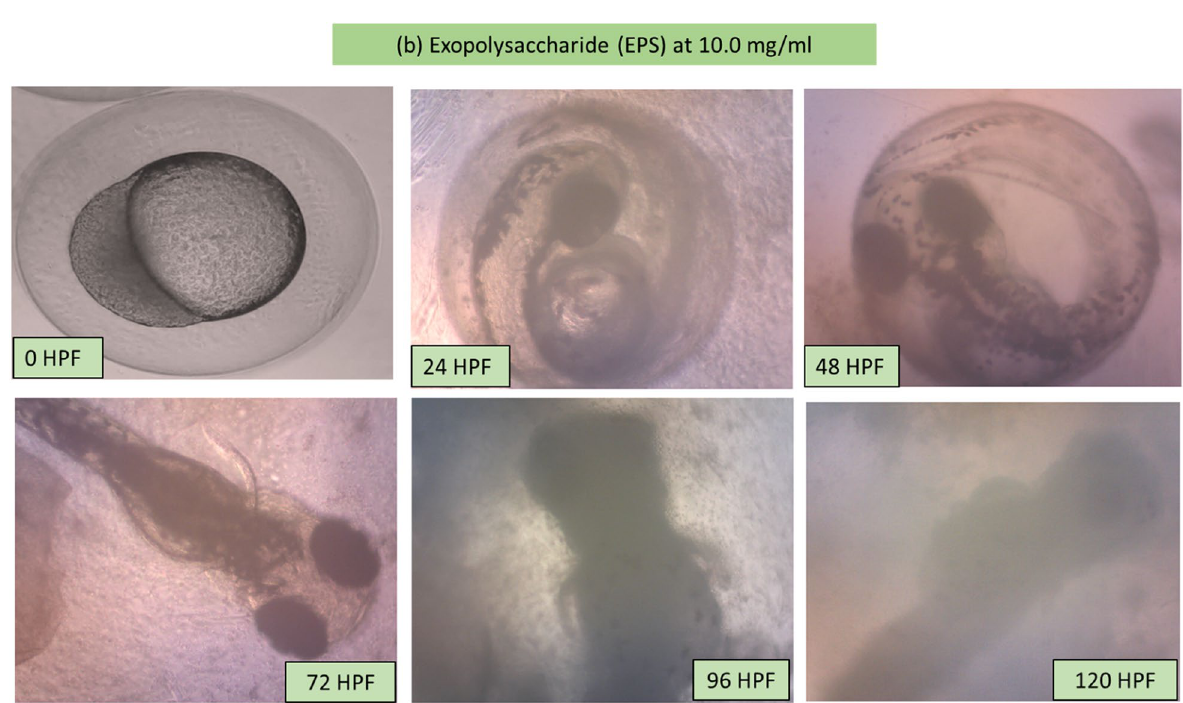
Figure 9. Illustrations of zebrafish embryo and larvae development after treated with Tiger Milk Lignosus rhinocerus strain ABI at high EPS concentration of 10.0 mg/mL. Descriptions were captured using an inverted microscope at 100X (0 and 24 HPF) and 40X magnification (48–20